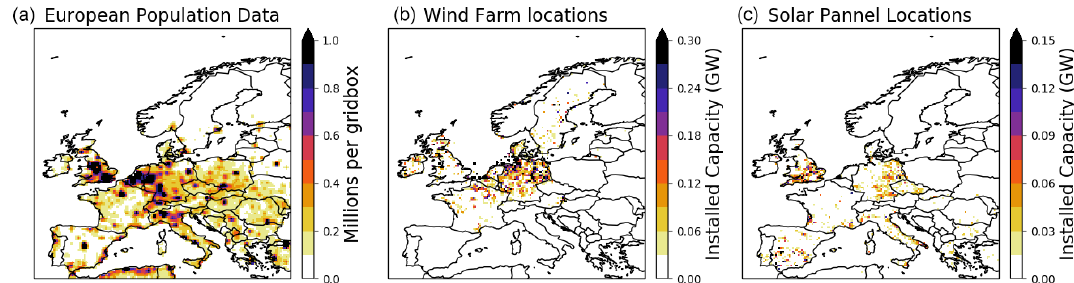
Figure 2. (a) Population data, (b) wind farm locations, and (c) solar farm locations over Europe used to create the datasets in this study, all interpolated onto the ERA5 reanalysis grid. See Appendix A for further details of the fields produced in each